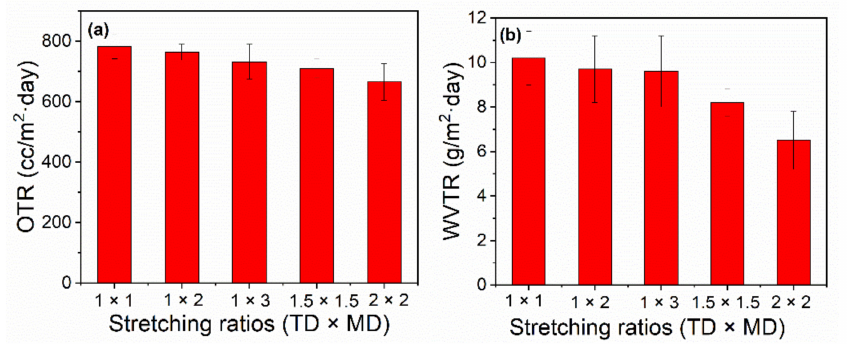
Figure 8. The gas barrier properties of PBAT-1.0 films under different biaxial stretching ratio. ( a ) OTR, ( b )